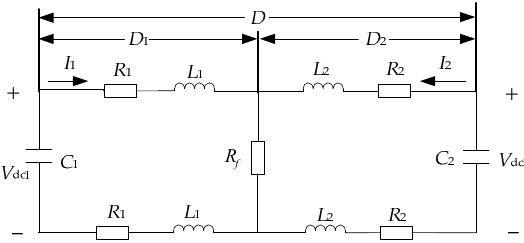
Figure 2. Equivalent circuit diagram of capacitance discharge phase under pole-to-pole short-circuit fault.